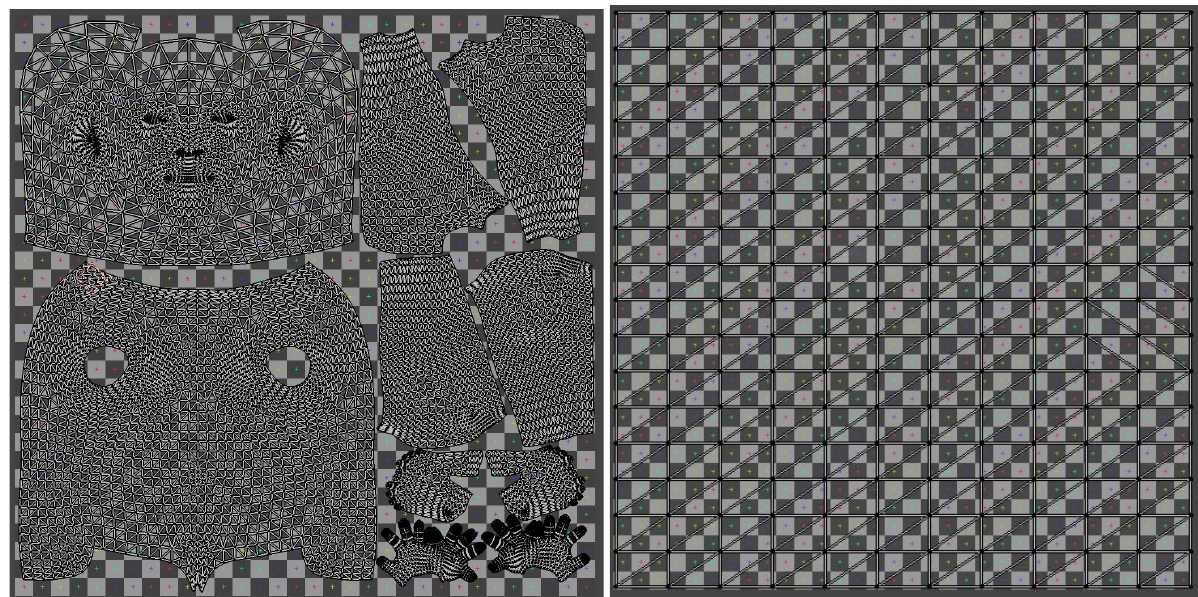
Figure 5. Default UV map of SMPL model for whole body [38] ( left ). UV map for the forearm after modification ( right